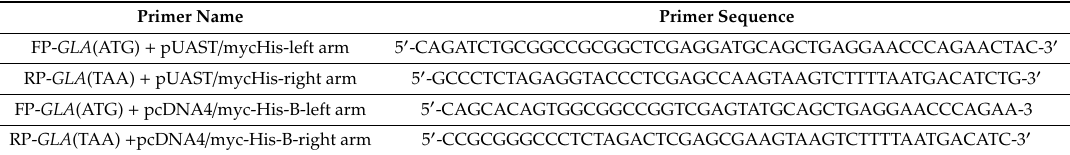
Table 1. Primers used for Gibson assembly.